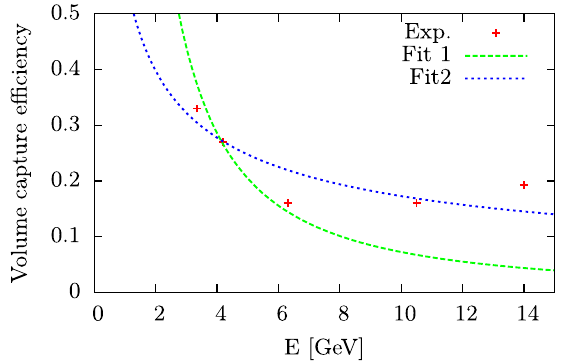
FIG. 18. The volume capture efficiency as given by 1 − P 1 from Table VI. “ Fit 1 ” is a fit to a function of the type aE − 3 = 2 and “ Fit 2 ” is a fit to a power function ð aE b Þ .